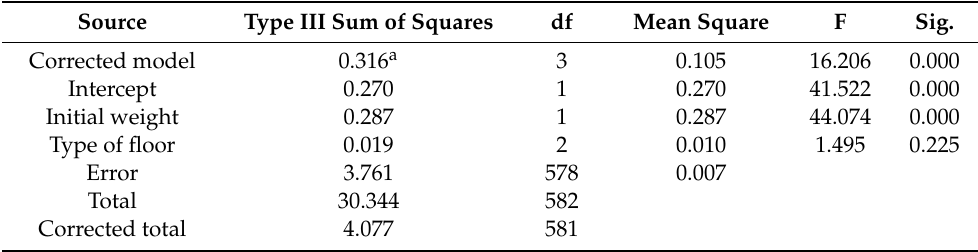
Table 7. Tests of between-subjects e ff ects table, in which the type of floor was the independent variable, the initial weight was the covariate, and the ADG was the dependent